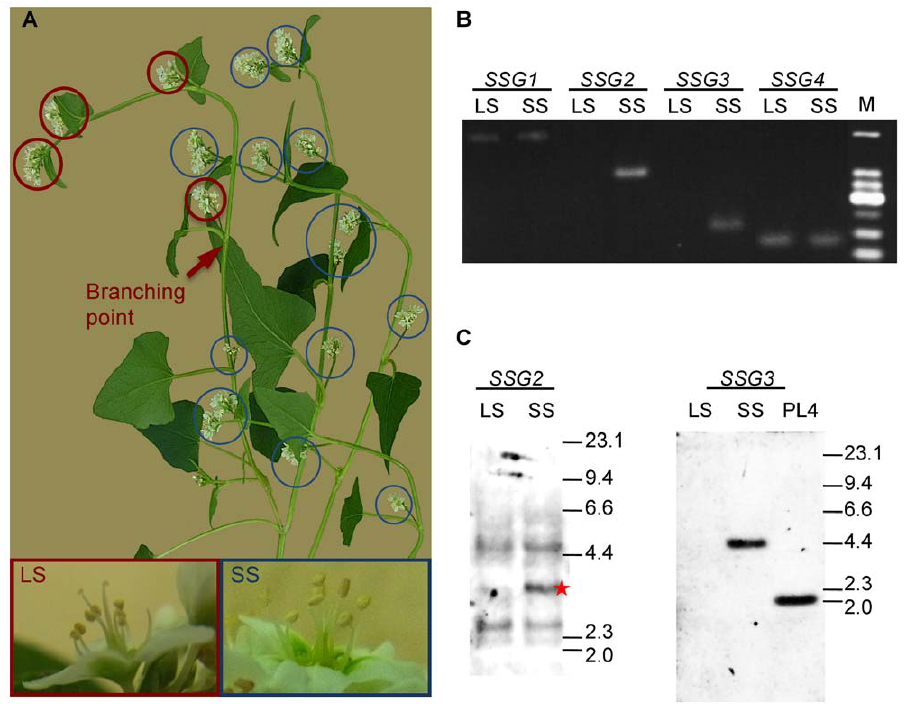
Figure 3. Analysis of a chimeric mutant plant and a short-styled-specific gene (SSG). (A) A chimeric plant generated by ion-beam mutagenesis. Red and blue circles indicate long-styled (LS) and short-styled (SS) flowers, respectively. (B) PCR amplification of gene fragments for SSG1-SSG4 using genomic DNA isolated from the chimeric plant as template. M, molecular marker (25-bp DNA ladder, Invitrogen). (C) Southern blot analysis of SSG2 and SSG3 ( S-ELF3 ) using genomic DNA isolated from the Kitawase cultivar (LS, SS) or Kyushu PL4 (PL4) as template. The star indicates the band corresponding to SSG2 . Fragment sizes of the l Hin dIII marker shown at the right are in kb.